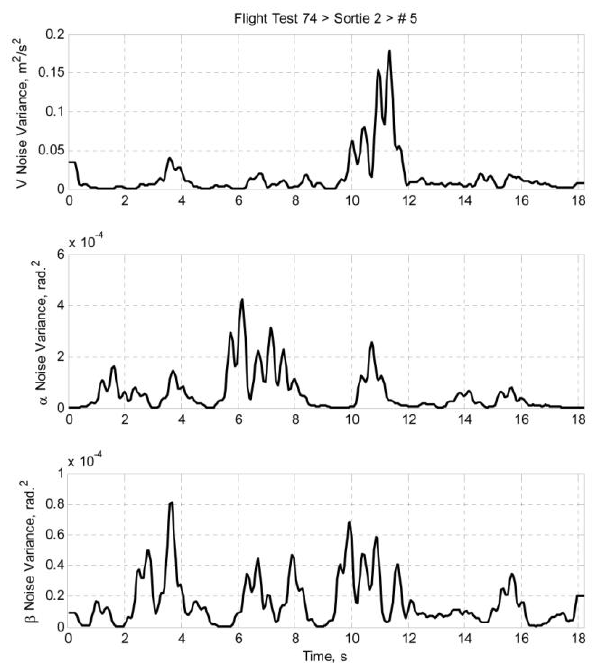
Figure 10. Airdata noise variance of